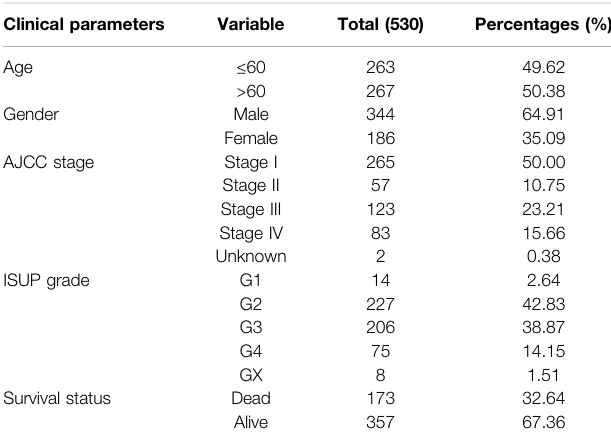
TABLE 1 | Clinical information of 530 ccRCC patients. Clinical